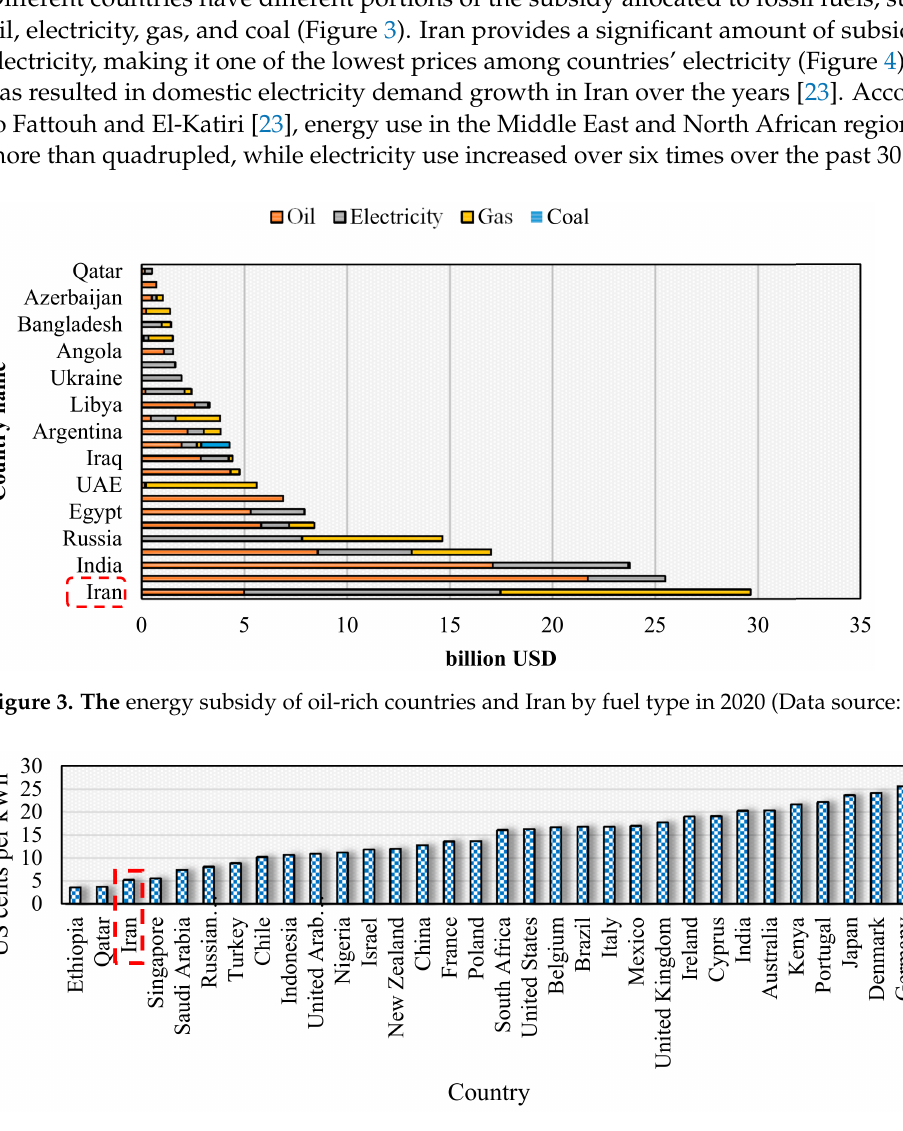
Figure 4. Electricity prices in different countries and Iran in 2019 (Data source: